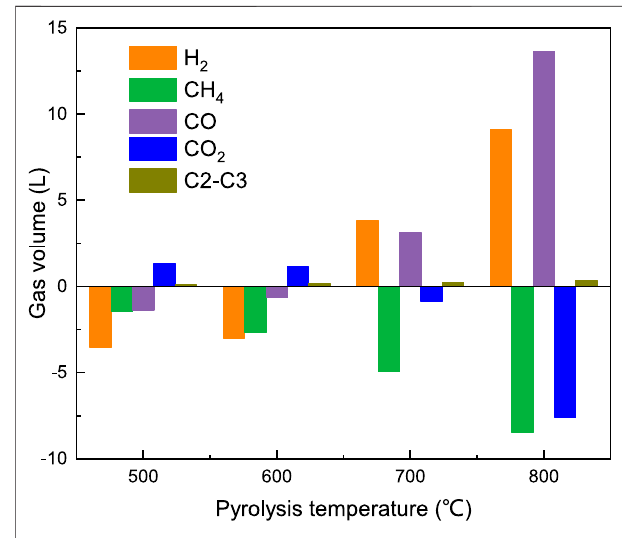
FIGURE 5 | Volume difference of the gas components between SFG plus CP-N 2 and CP-CRS versus temperature.